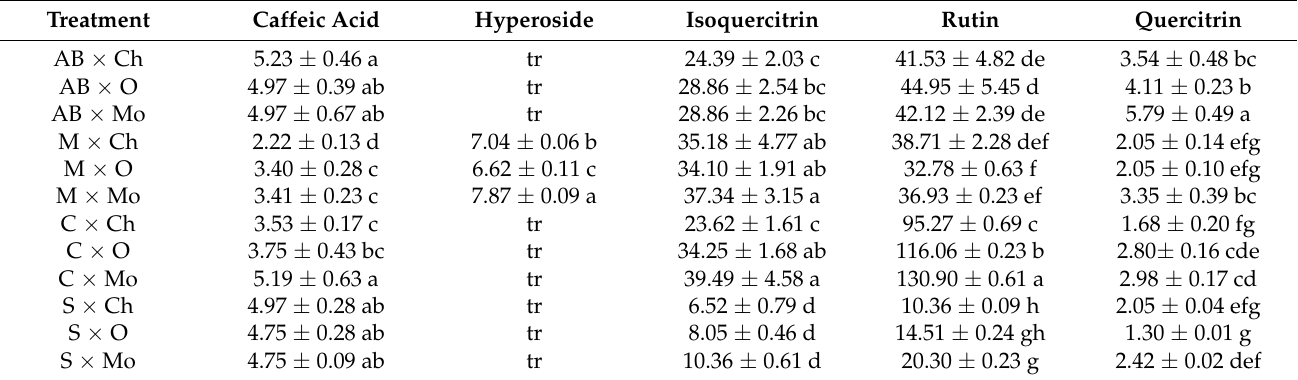
Table 8. Interaction between cultivar and fertilization type on phenolic compounds ( µ g · mL − 1